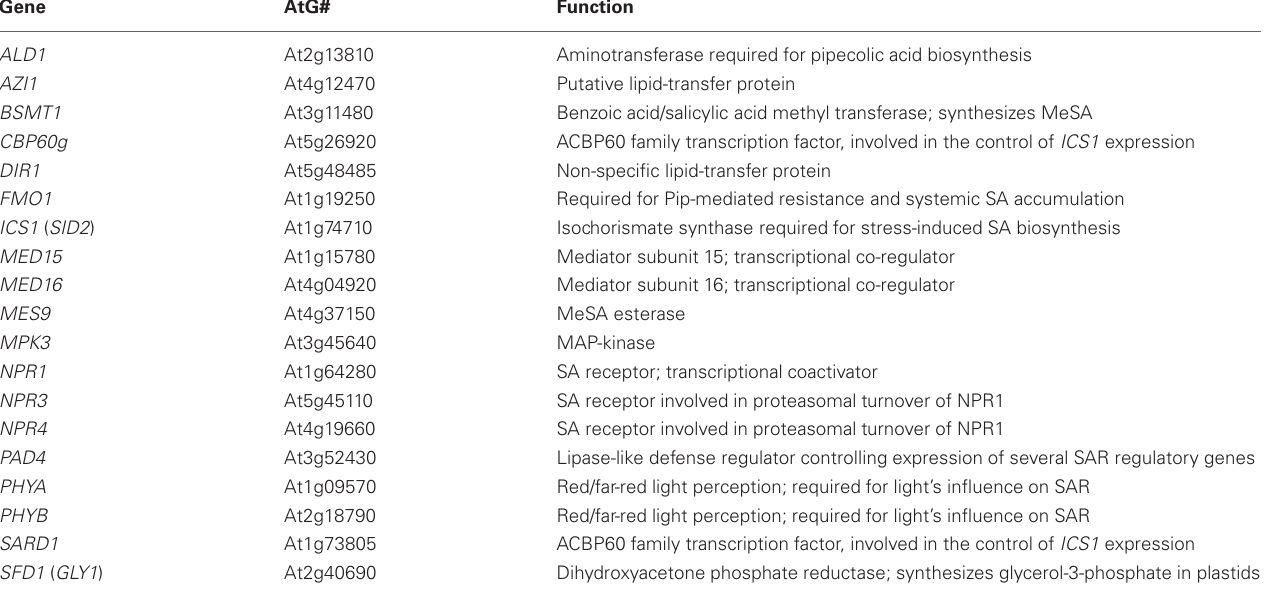
Table 1 | Arabidopsis genes involved in SAR.